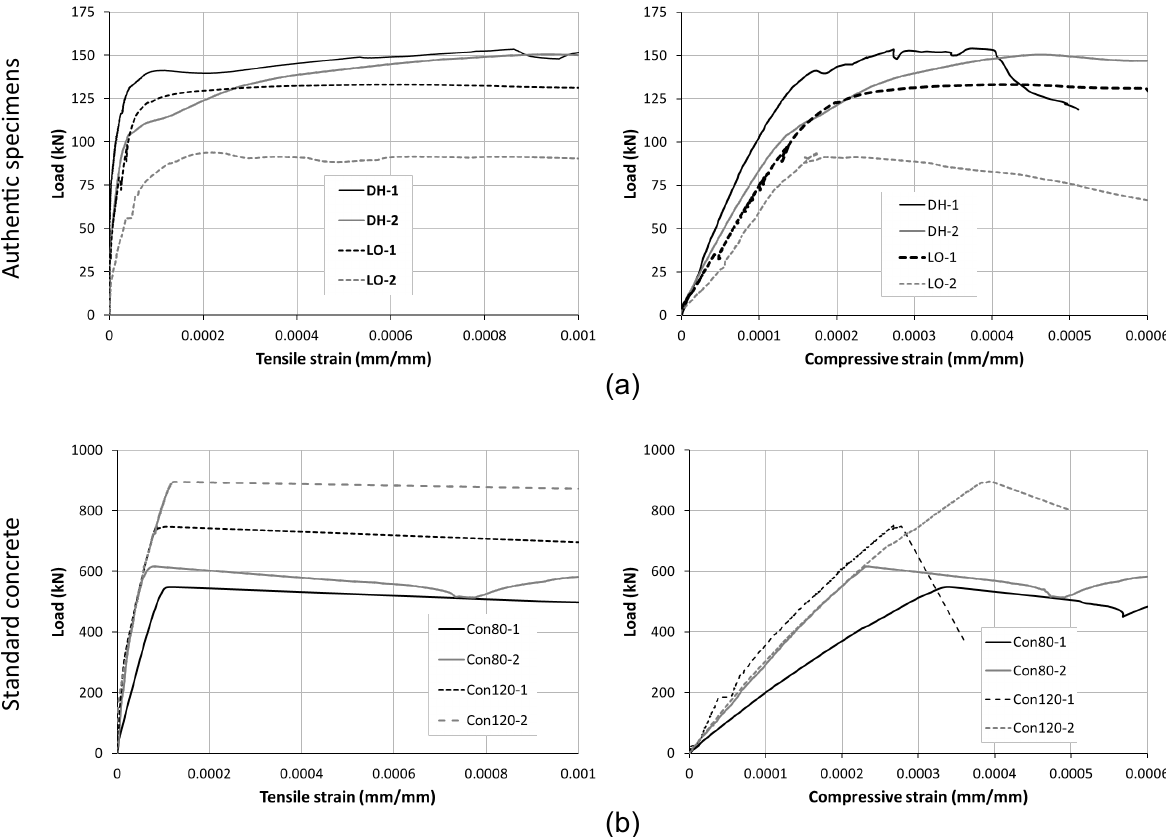
Figure 5. Diagonal compression tests: ( a ) load versus tensile/horizontal strain and ( b ) load versus compression/vertical strain of all